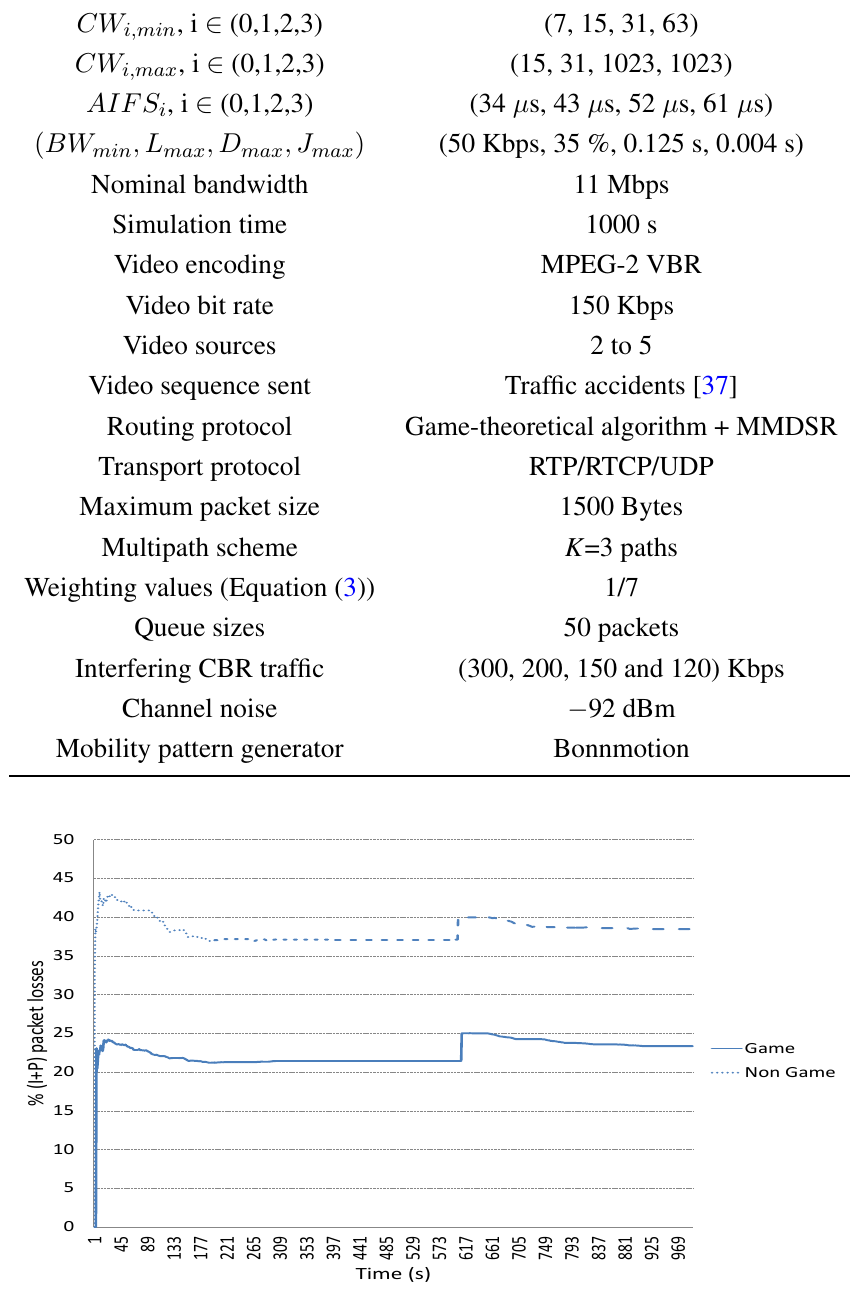
Figure 9. Percentage of packet losses vs time ( N = 3